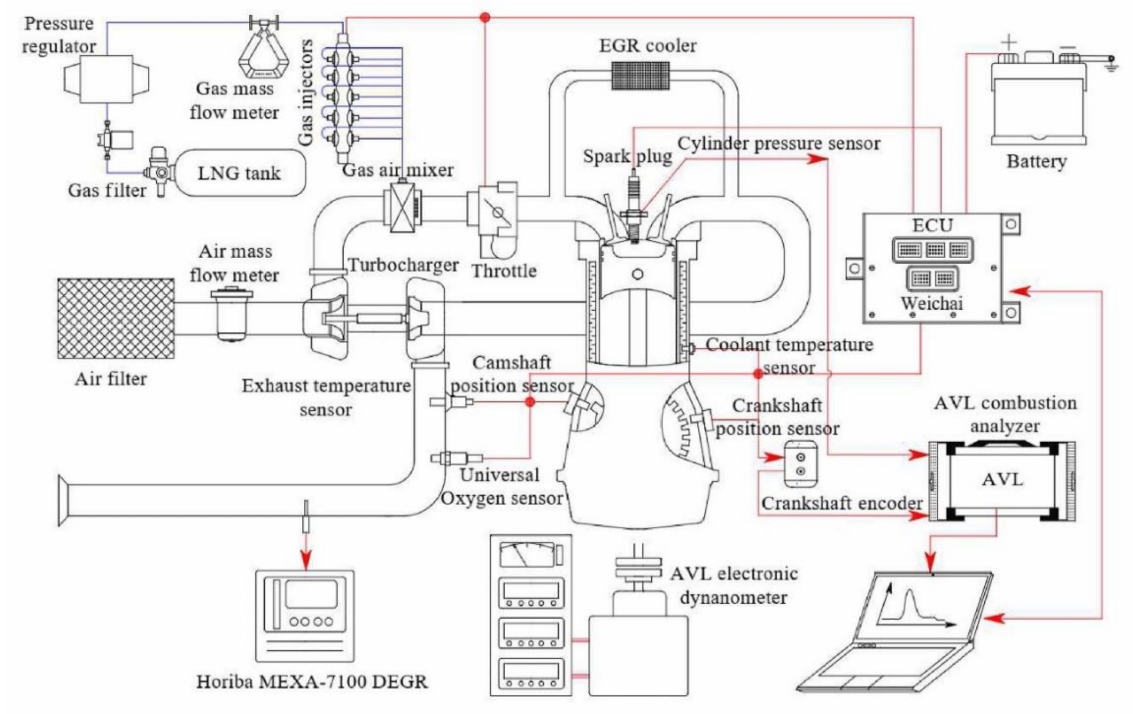
Figure 1. The schematic diagram of the experimental